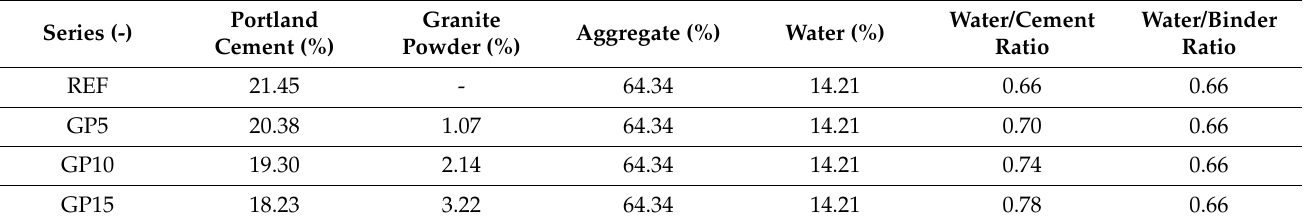
Table 3. The proportions of the components of the designed cement mortar